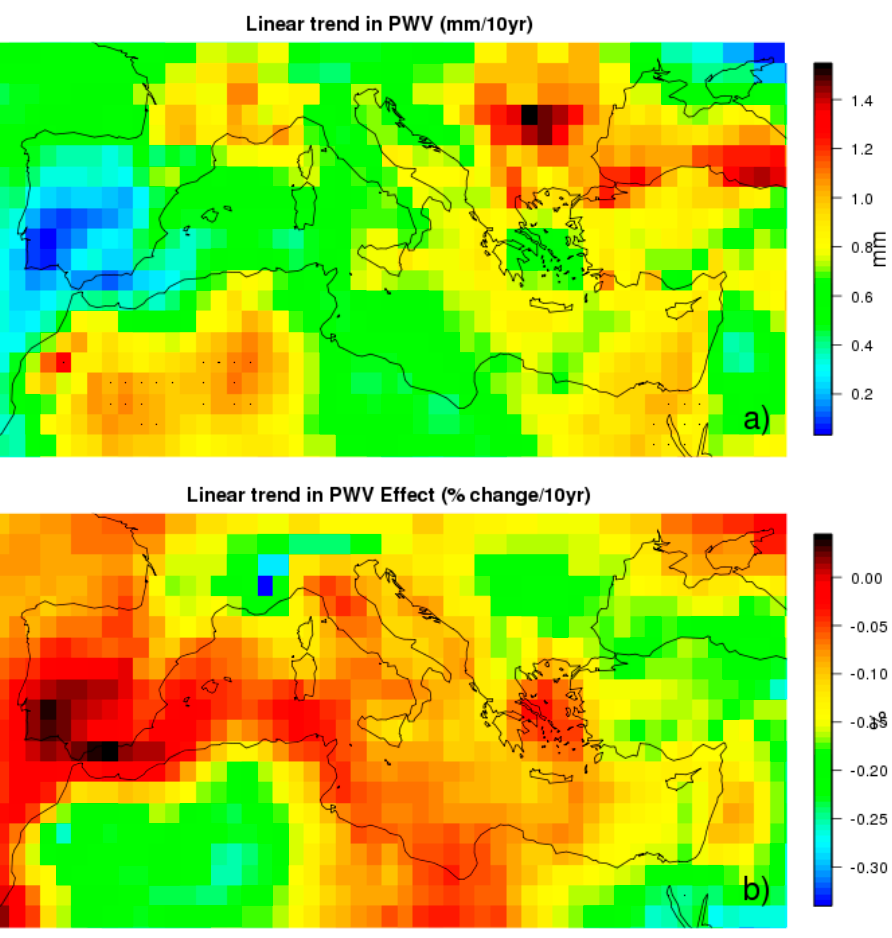
Figure 9. Spatial distribution of linear trend in (a) PWV and (b) PWV effect for 2000–2018 per decade. Pixels with levels of significance p <0.05 are marked with a black dot. Pixels with levels of significance p < 0.05 are marked with a black